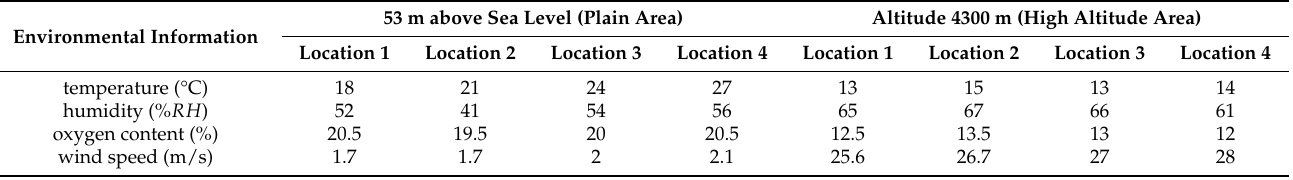
Table 3. Environmental information of different locations at the same